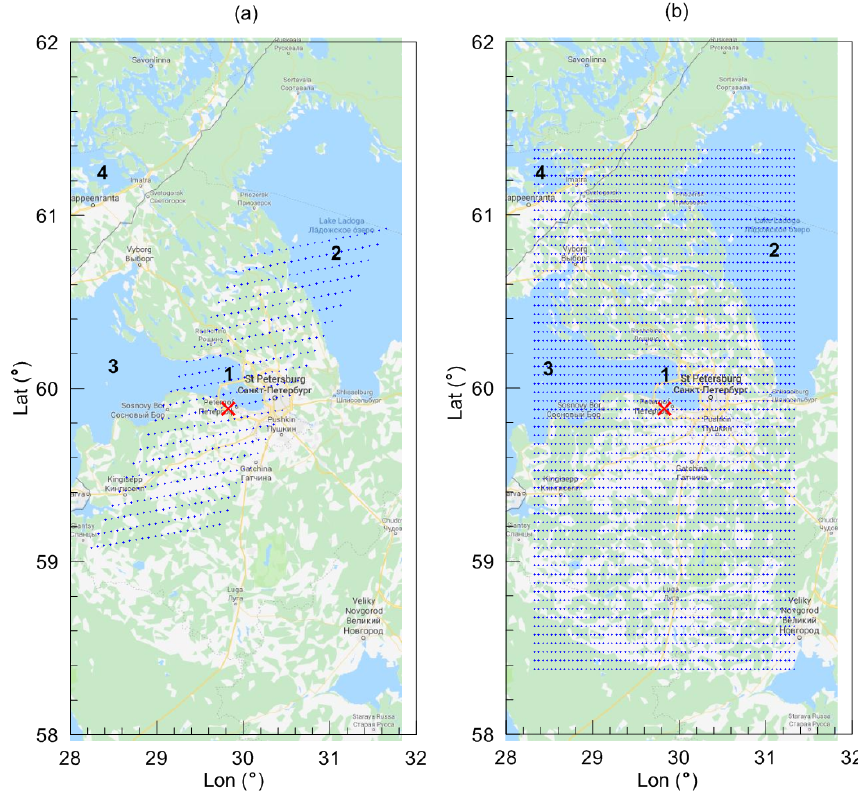
Figure 1. The location of 441 SEVIRI measurement pixels (a) and 3721 AVHRR measurement pixels (b) selected for analysis in the large terrain. The position of the HATPRO radiometer is marked by the red cross. The black numbers identify the following objects: 1 – Neva Bay, 2 – Ladoga Lake, 3 – Gulf of Finland, 4 – Saimaa Lake. Map data © 2019